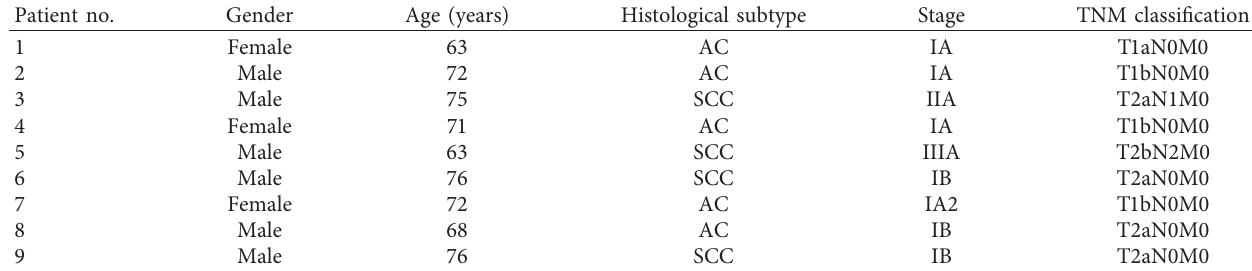
Table 1: Characteristics of patients from whom samples were obtained. Patient